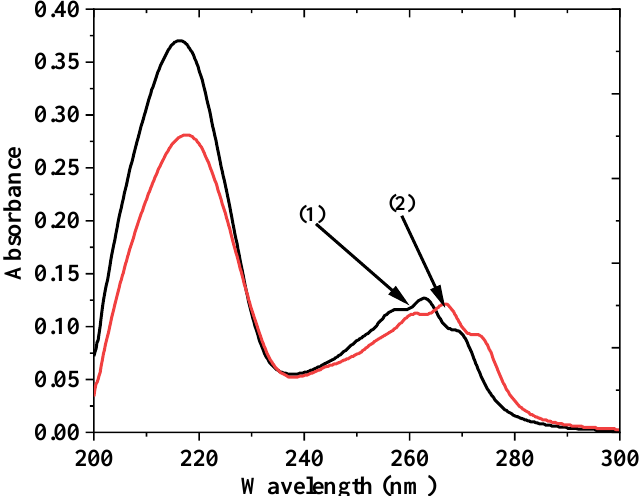
Figure 1. The UV-vis spectra of (1) 5 × 10 − 5 mol · L − 1 vitB1 and (2) 2.5 × 10 − 5 mol · L − 1 Eu (III)– (vitB1) 2 complex in methanol at room temperature.